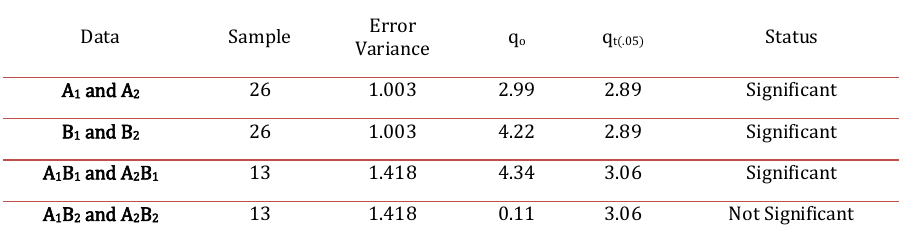
Table 4. The Summary of Tukey’s HSD